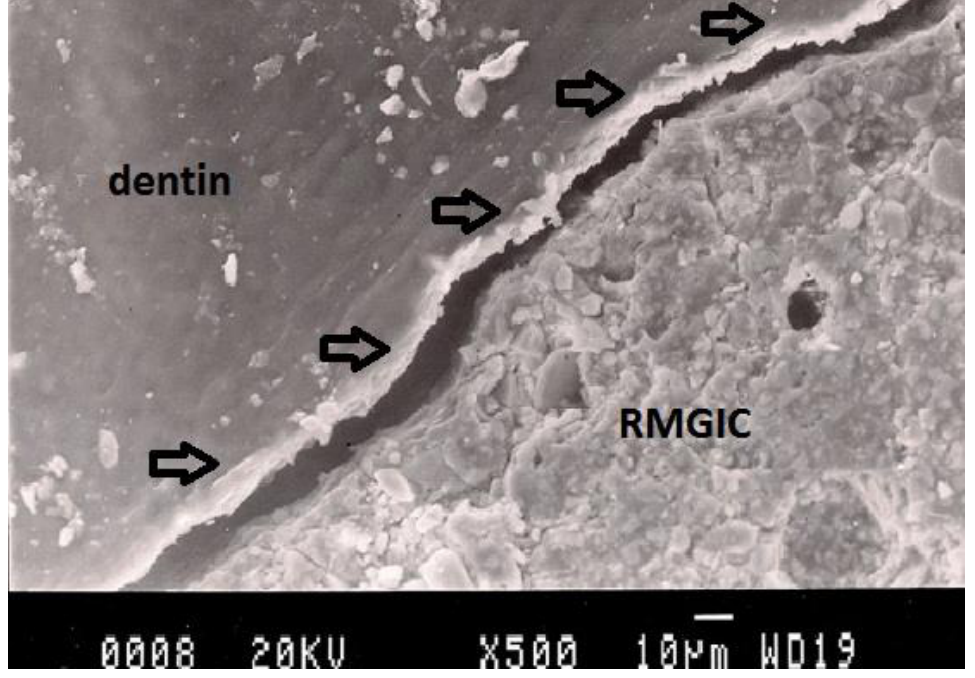
Figure 5. Representative SEM photomicrograph of a Group 4 specimen. The arrows indicate microgap between resin-modified glass ionomer cement (Vitremer) and